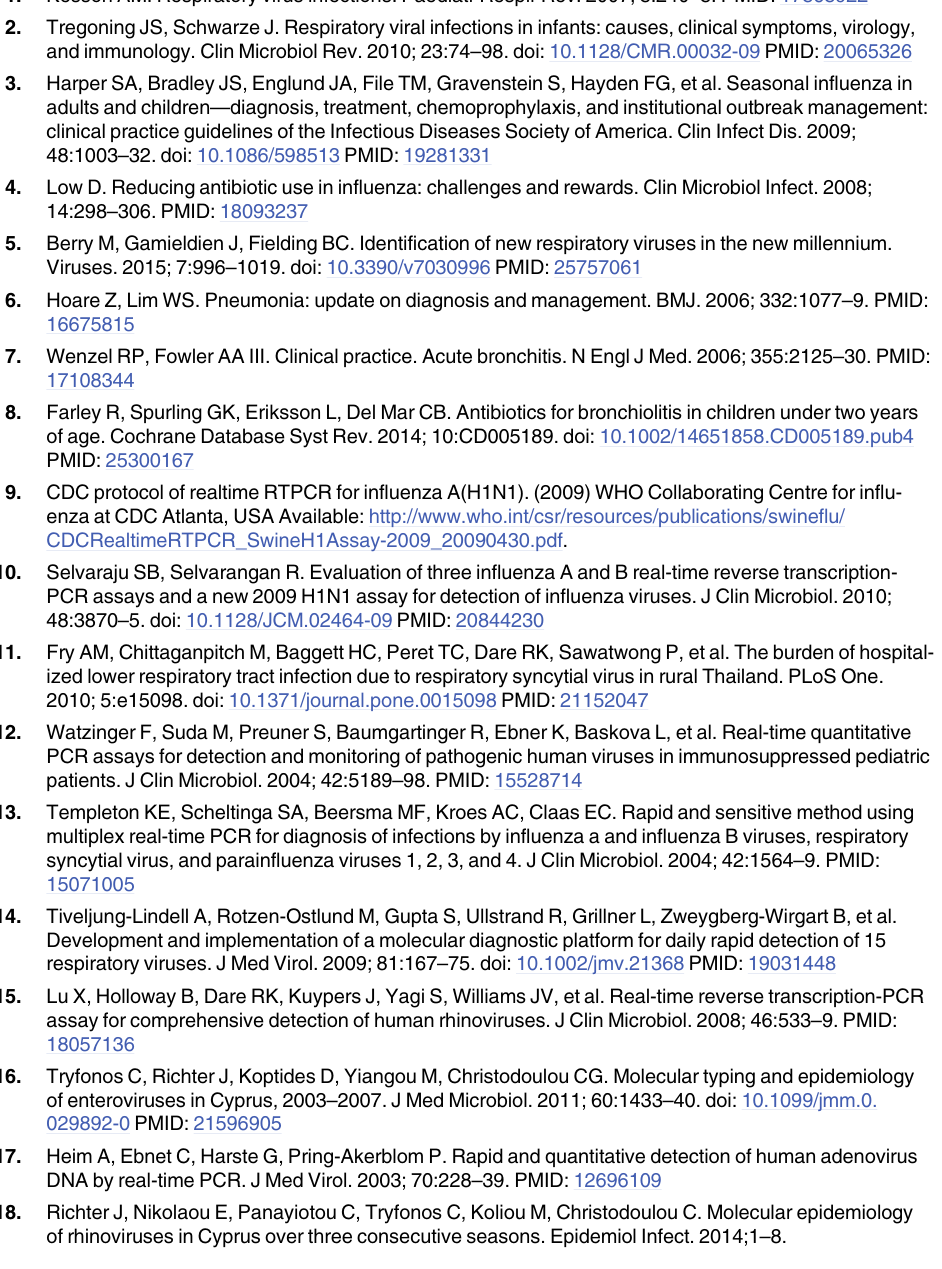
S1 Table. Pearson Correlation coefficients for observed viral co-infections.